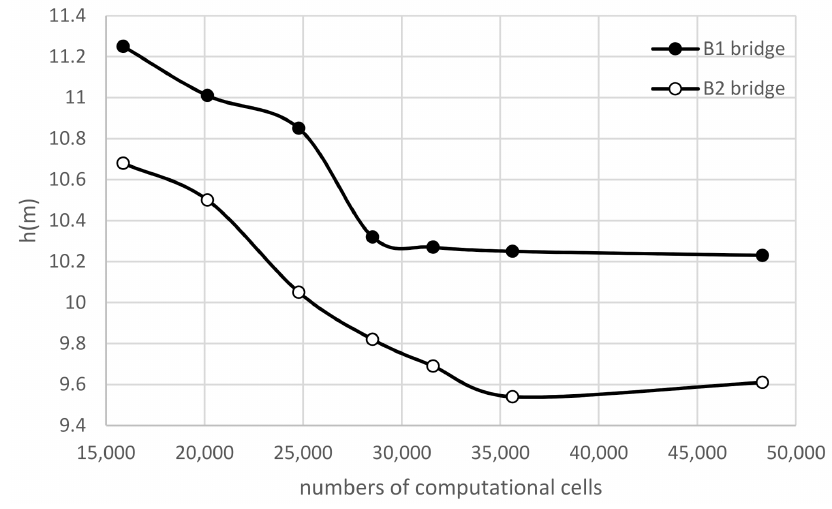
Figure 13. Maximum flow depth versus different numbers of computational cells.